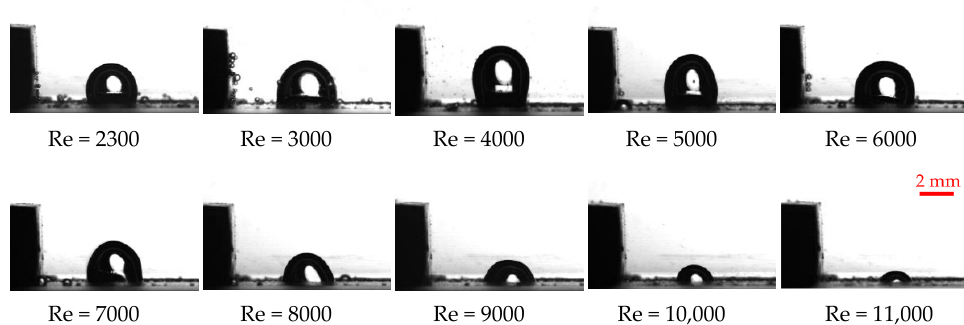
Figure 10. Bubble adhesion diagrams at different Reynolds numbers.